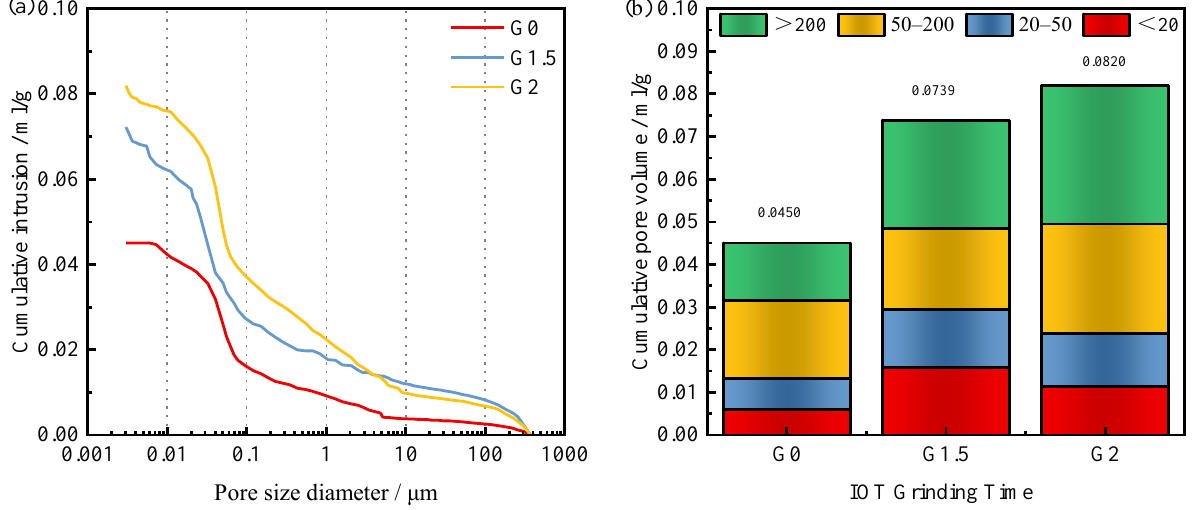
Figure 9. The influence of IOT grinding time on the ( a ) cumulative intrusion volume, and ( b ) pore volume distributions of the 28-d concrete.